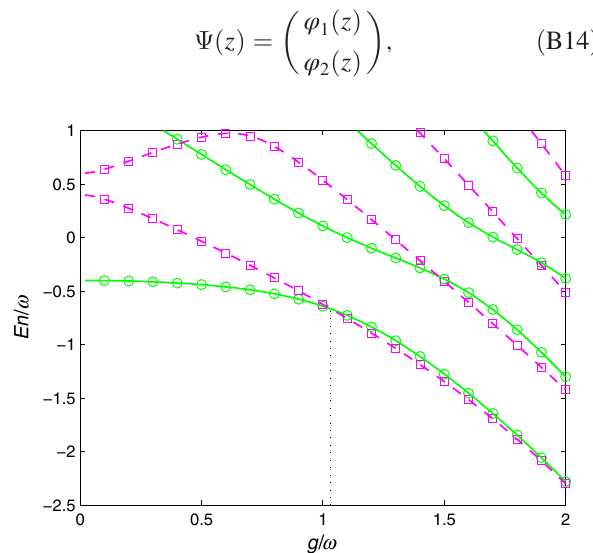
FIG. 7. Ground-state level crossing. The ground-state energy and the first-excited-state energy are crossed for the anisotropic Rabi model with Z 2 symmetry. The parity of the ground state changes when passing through the crossing point. Here, ϵ ¼ 0 for keeping Z 2 symmetry; we choose Δ ¼ 0 . 4 and λ ¼ 0 . 5 , so g ¼ ffiffiffiffiffi p 4 = 15 and E e 0 ¼ − ð 2 = 3 Þ due to Eqs. (11) and (12). The solid green lines are for positive parity, and the dashed purple lines are for negative parity. The circles and blocks are numerical data; they agree well with the analytical results shown in the lines. Part of this figure is shown in the upper panel of Fig.